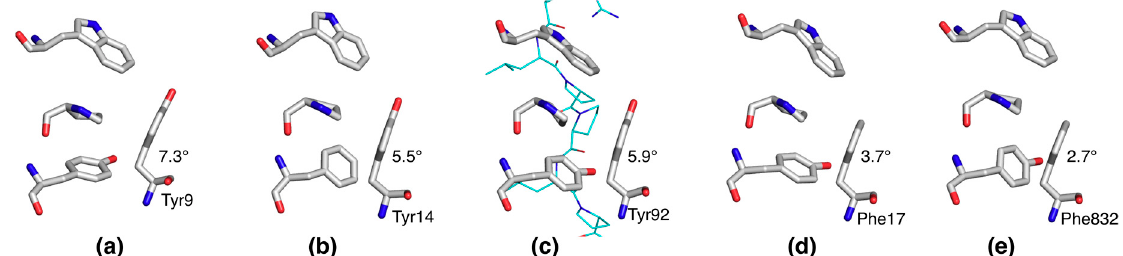
Figure 5. A conserved bent aromatic residue in SH3 domains. Shown above is the peptide-binding site, composed of several conserved aromatic residues, of the atomic-resolution SH3 domain structures from ( a ) yeast Bzz1, ( b ) yeast Bbc1, ( c ) chicken c-Src bound to a peptide ligand, ( d ) rat betaPIX, and ( e ) human ponsin. The bending angle of the outlier aromatic residue (bottom right) is shown for all structures.